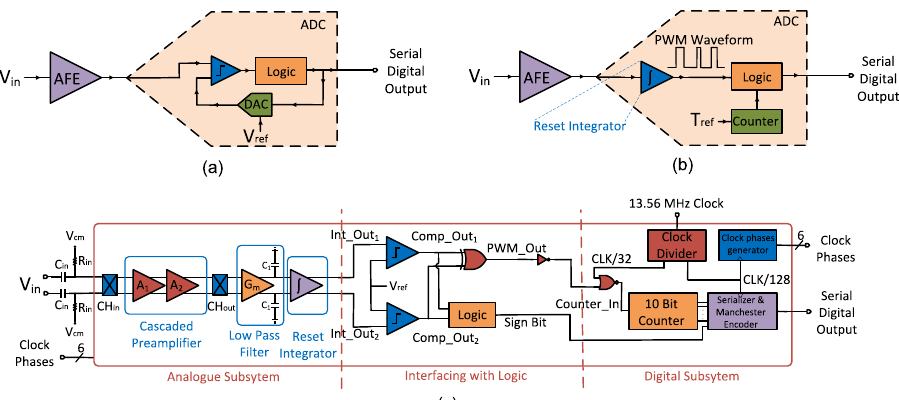
Fig. 2 System architecture. a Conventional biopotential acquisition system, b System-level diagram of the ECG acquisition system presented in this work, and c Detailed architecture of the presented